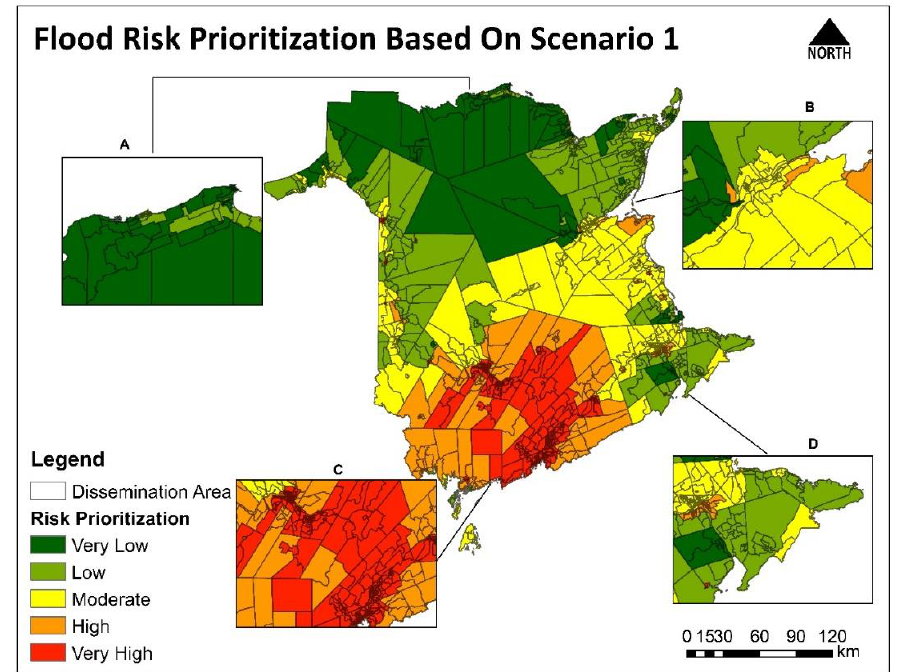
Geosciences 2020 , 10 , x FOR PEER REVIEW Figure 5. Flood risk prioritization based on Scenario 1 using zonal statistics.